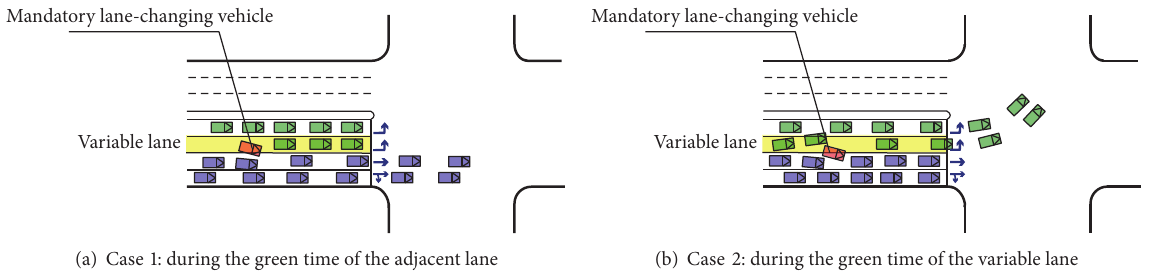
Figure 6: Mandatory lane-changing. Table 7: Number of the mandatory lane-changing